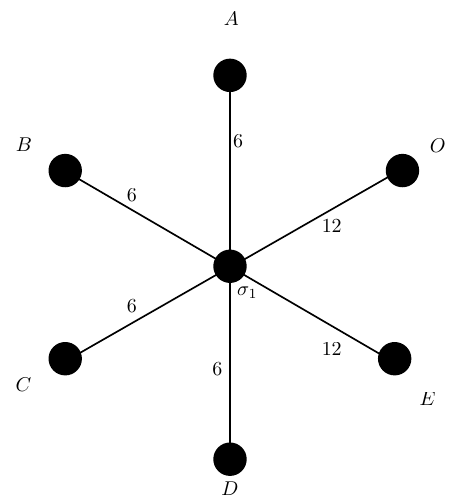
Figure 23 . A graph with five boundary vertices A, B, C, D, E and purifier O along with one internal vertices σ . Edge capacities are labeled for each 1